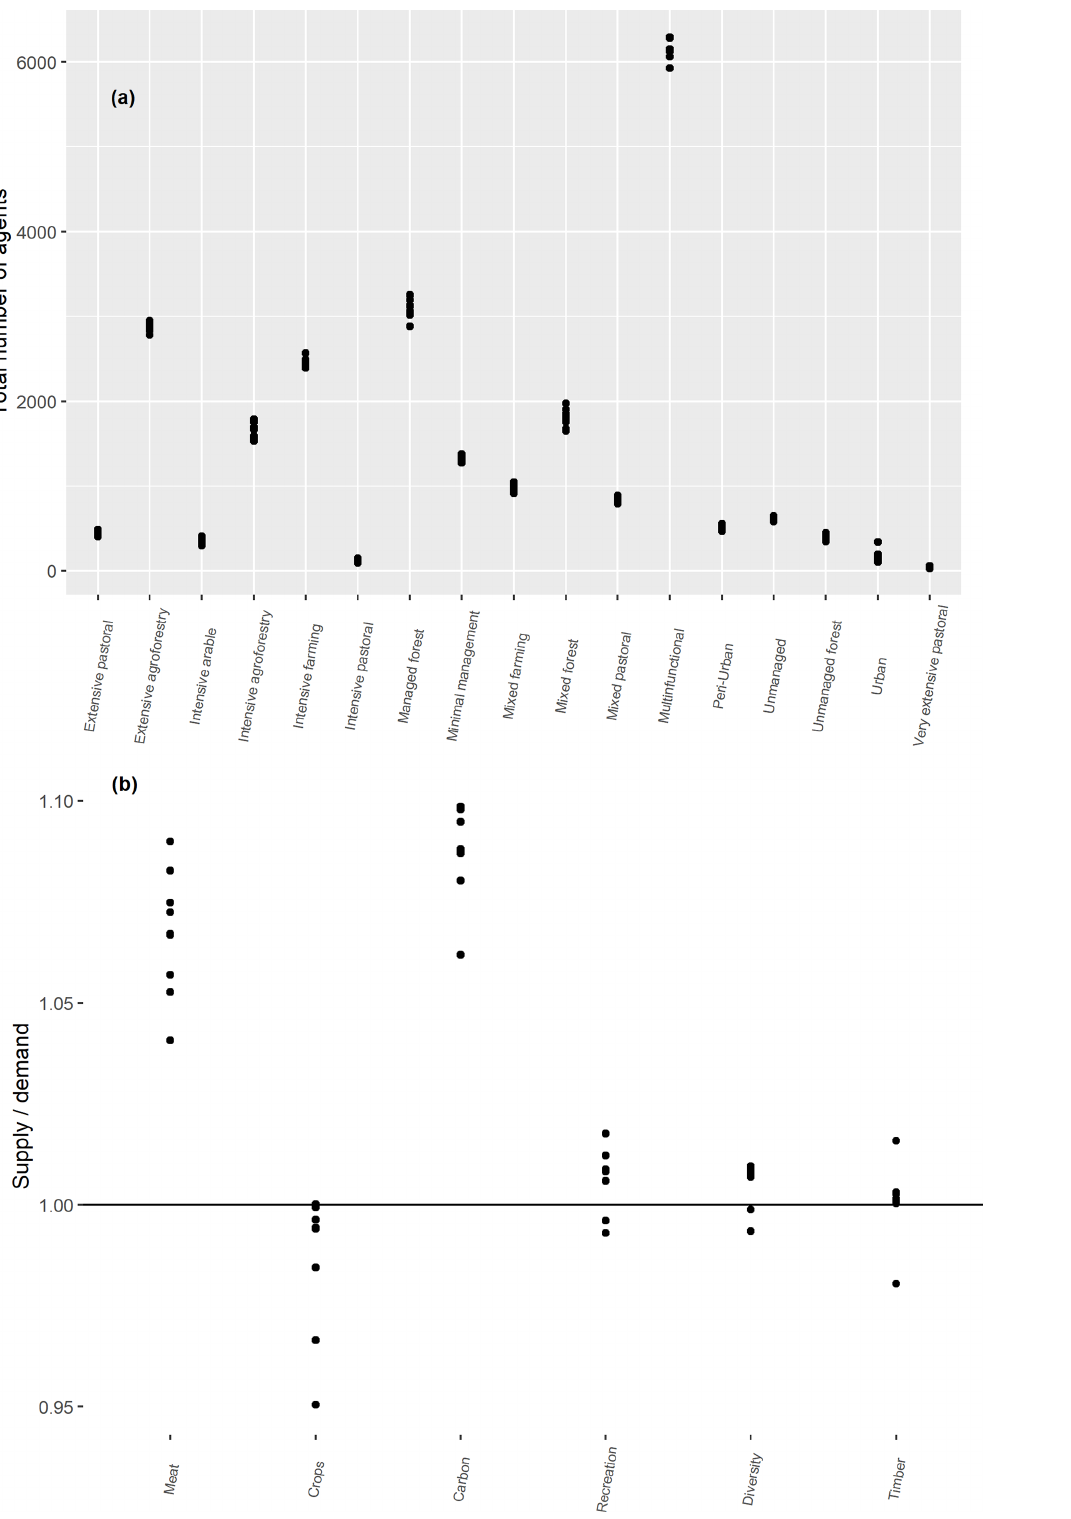
www.earth-syst-dynam.net/10/809/2019/ Earth Syst. Dynam., 10, 809–845,